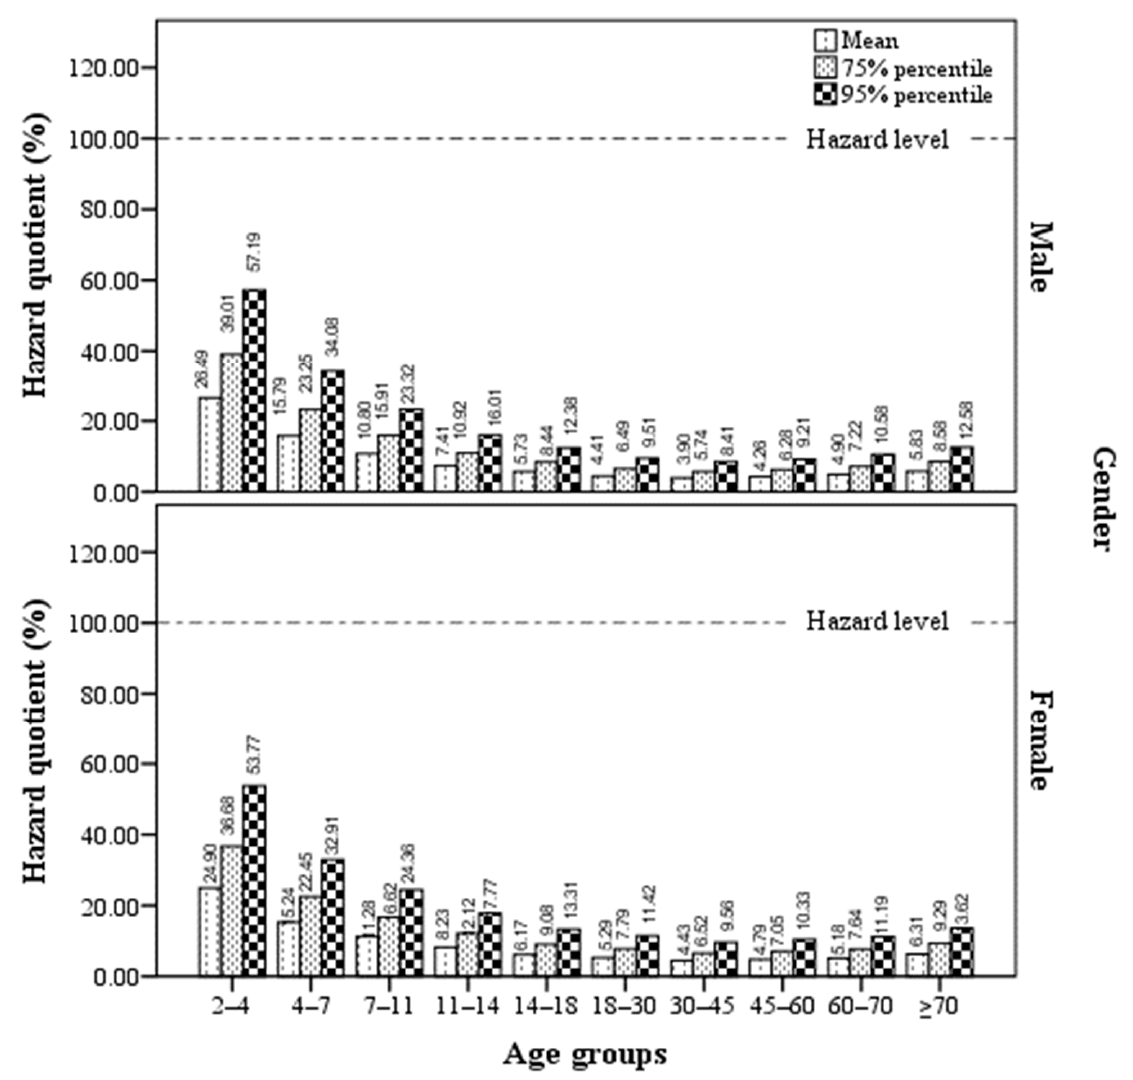
Figure 1. Variation in the hazard quotient (HQ) values of AFM1 exposure for milk consumers in different age-sex groups. The HQs of AFM1 for each age group were lower than the hazard limits, with the highest HQ of AFM1 in children (2–4 years of age) and the lowest in adults (30–40 years of age). The HQs were similar between ten age groups of male and female milk consumers. Note: (1) To calculate estimated daily intake (EDI), the concentrations of AFM1-negative milk samples were assumed to be 2.5 ng/L (half of the detection limit of 5 ng/L), from which the mean, 75% percentile, and 95% percentile concentrations were calculated to be 4.78, 7.04, and 10.32 ng/L, respectively. These concentrations were then used to calculate the corresponding EDI values. (2) %HQ = EDI/tolerable daily intake (TDI) × 100, where the TDI value was set as 0.2 ng/kg bw/day as shown by Kuiper-Goodman (1990) [19]. (3) Milk consumers with HQ values higher than 100% are at health risk.